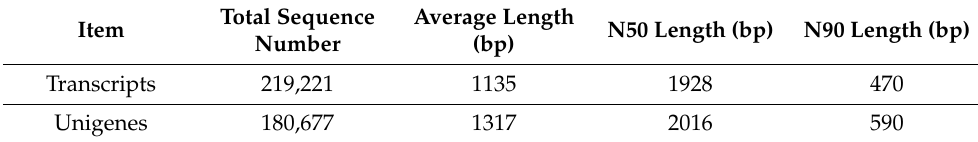
Table 2. Assembly results of transcriptome using Trinity software.